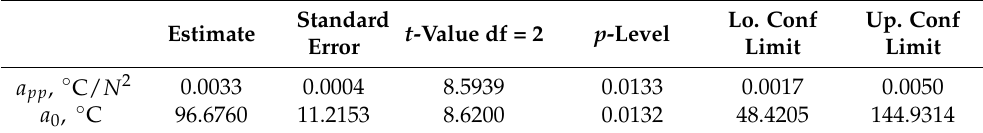
Lo. Conf Up. Conf Limit Limit